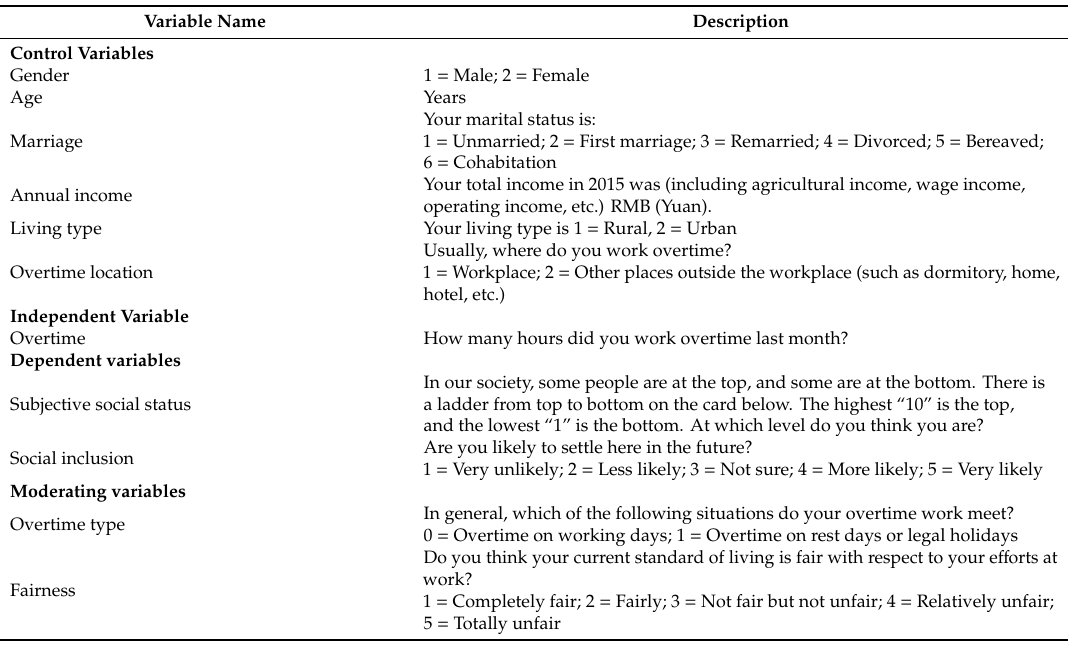
Table 1. Definition and description of variables in the